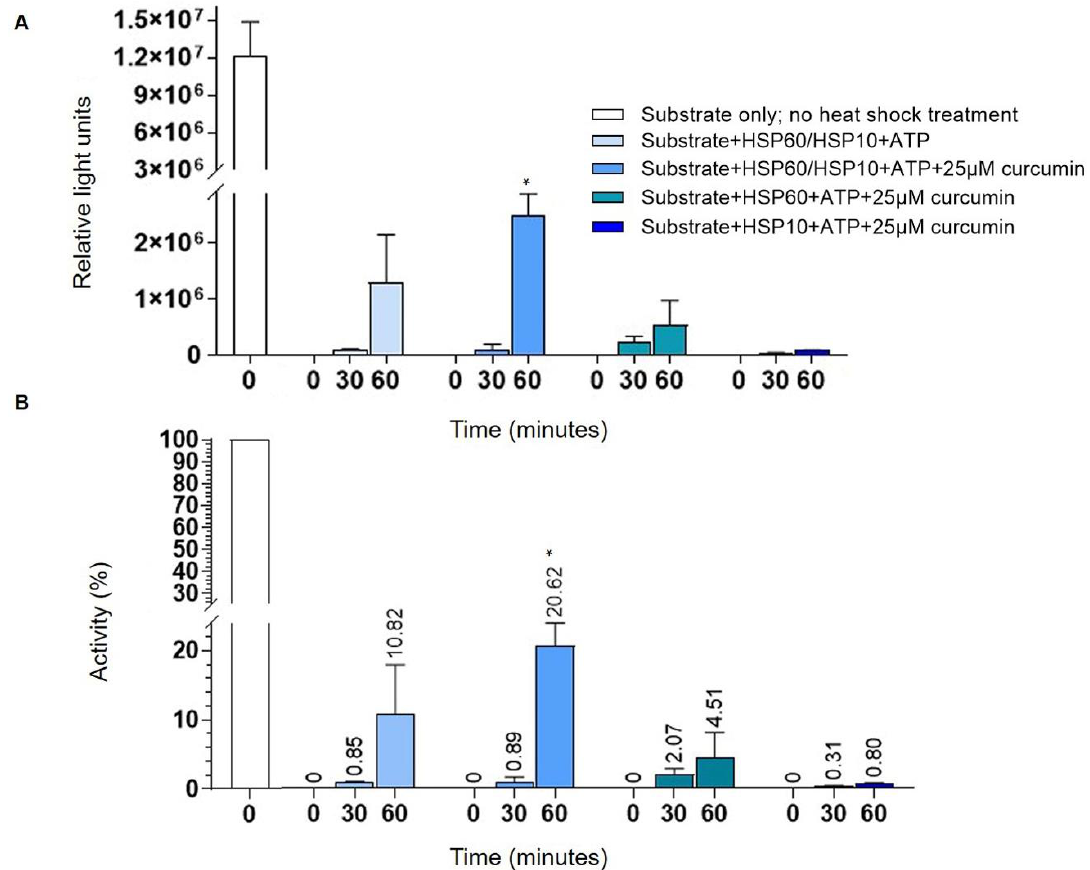
Figure 4. Folding test: At indicated times 30–60 min, aliquots were taken from each of the reactions and added to assay wells containing 50 µ L of Luciferin reagent. Luminescence measurements were taken using a GloMax ® 96 Microplate Luminometer (Promega Corporation, Madison, WI, USA) (Substrate: Glow-Fold ™ Substrate Protein). ( A ) The graph shows the average of three independent experiments. The folding test demonstrated that curcumin (25 µM) significantly promoted the refolding activity of HSP60/HSP10 complex after 60 min of reaction (* p < 0.01 vs. Substrate + HSP60/HSP10 + ATP, Substrate + HSP60 + ATP + 25 µM curcumin, Substrate + HSP10 + ATP + 25 µM